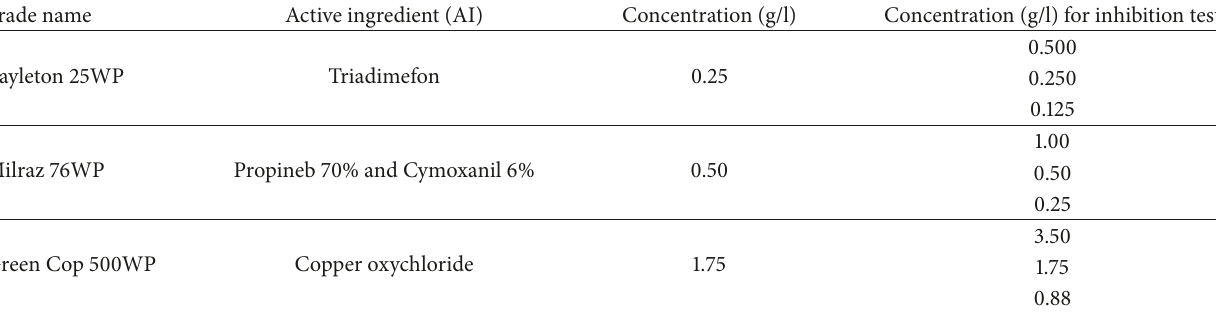
Table 1: Fungicides concentrations used to determine sensitivity of Colletotrichum gloeosporioides isolates from diseased avocado